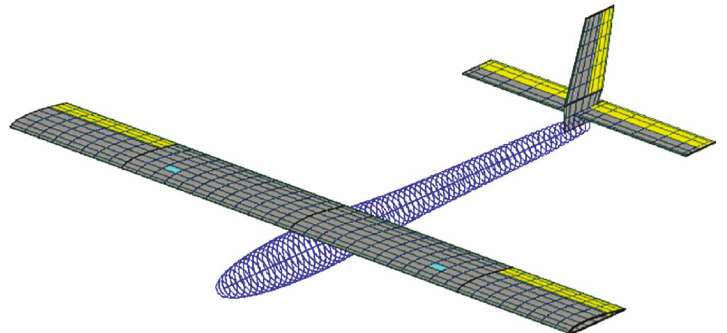
Figure 1: The vortex lattice model of an experimental SUAV with pressure sensors marked by blue spots on the main wing